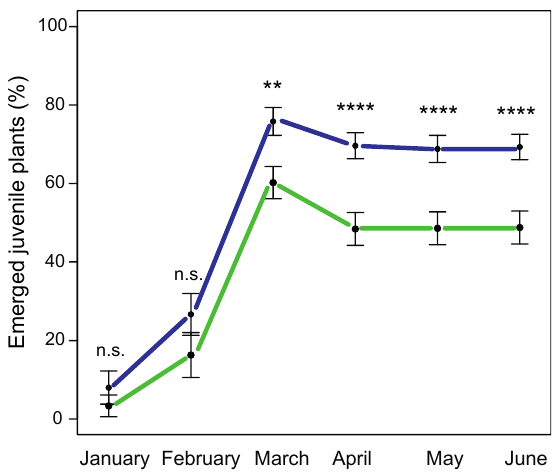
Figure 6. Accumulation curves of emerged juvenile plants of Lamium galeobdolon subsp. argentatum (blue line; in %) and Lamium galeobdolon subsp. galeobdolon (green line) from January to June. As- terisks indicate significant differences between the two subspecies in a particular month (** p < 0.01, **** p < 0.0001, n.s. not significant). Differences were tested using Chi 2 tests. Mean values of all populations ± s.e. are shown; n =